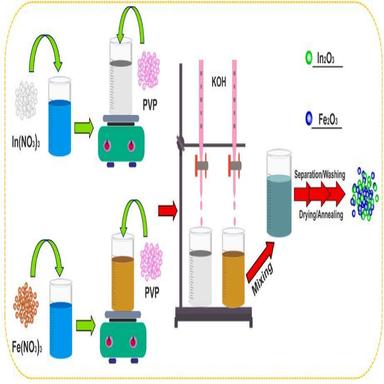
Schematic scheme for the synthesis of nanocomposites.